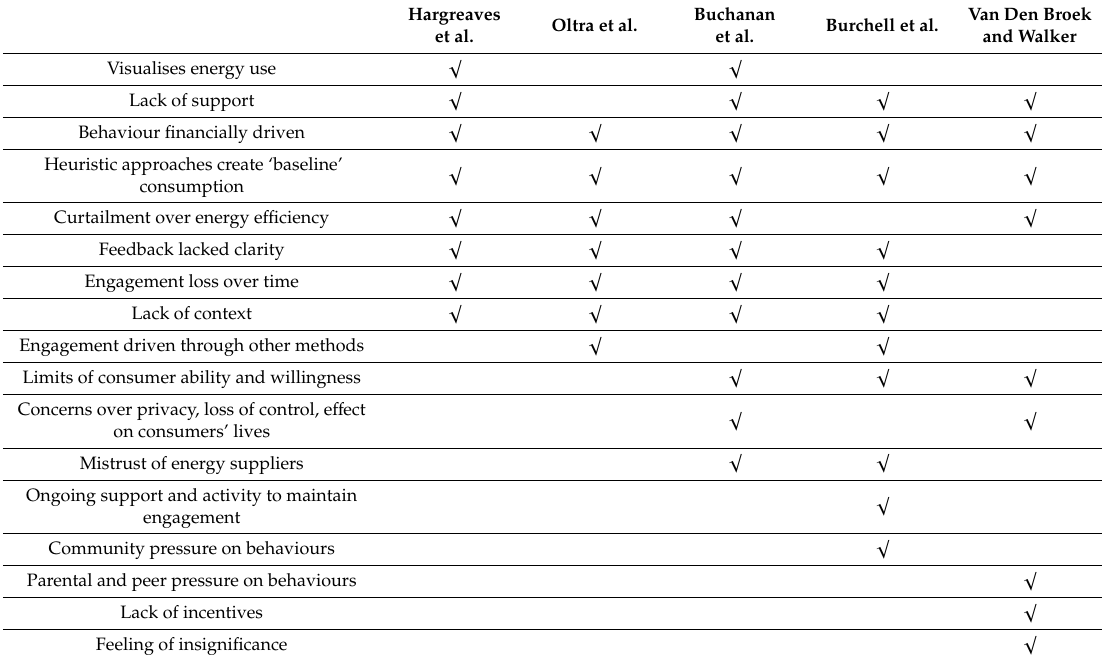
Table 1. Highlights some of the major findings from each set of